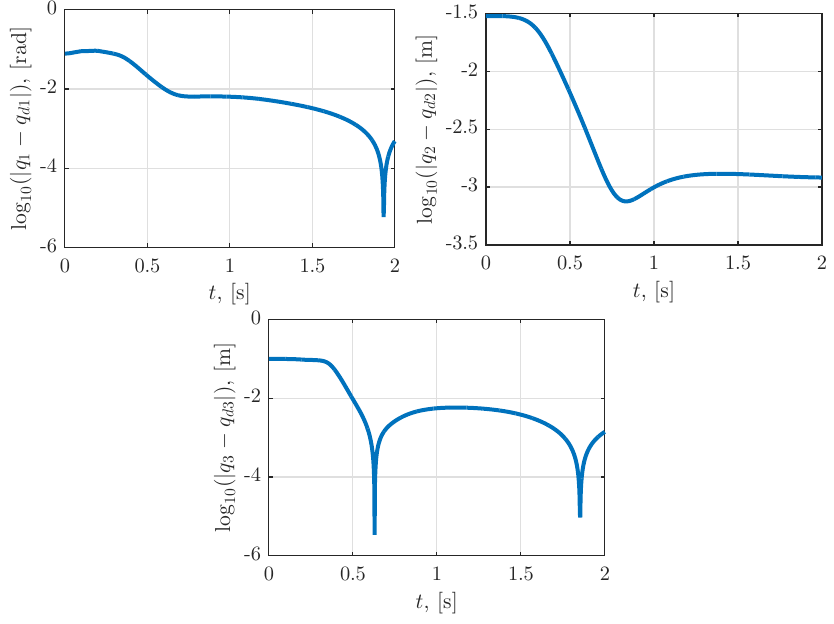
Figure 5. Time dependence of the positioning